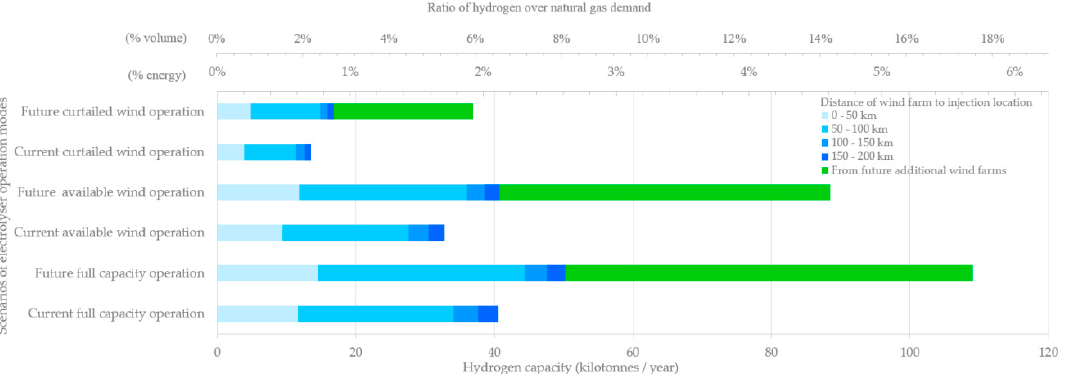
Figure 12. Distribution of hydrogen capacity relative to Irish natural gas demand, as functions of distance from WHS to injection points.